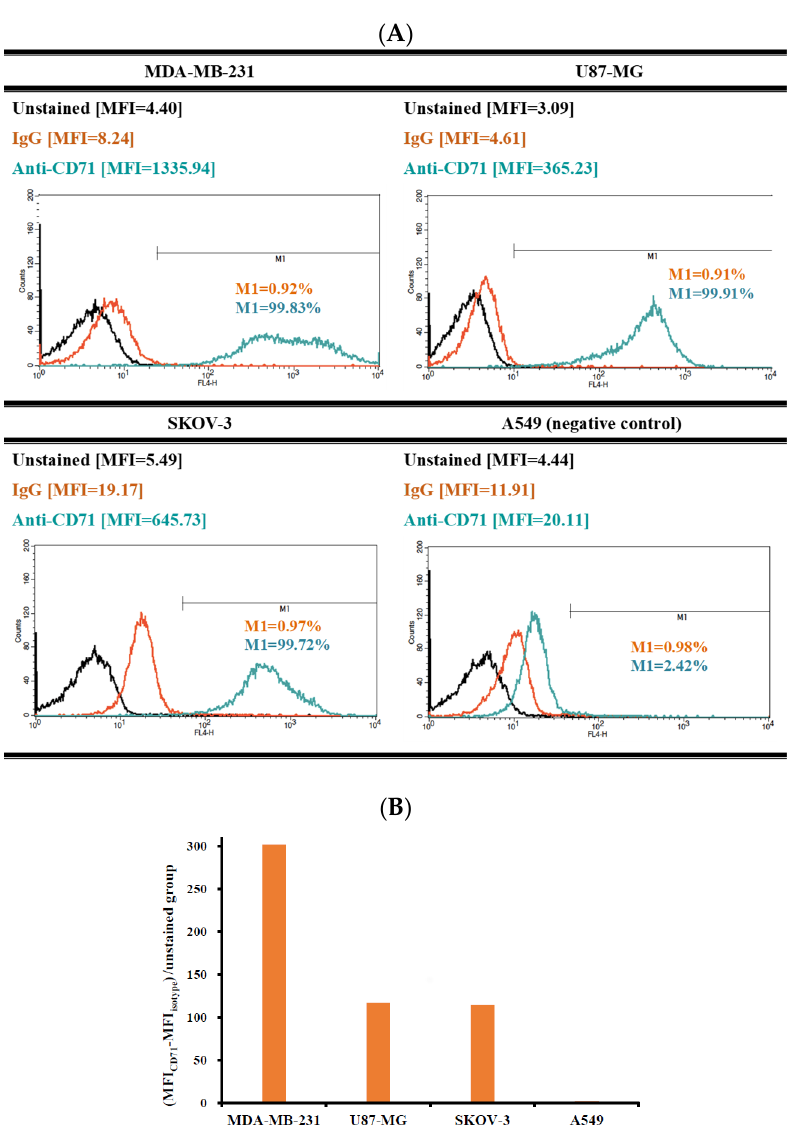
Figure 4. ( A ) The cytometric histograms of various cancer cells stained with anti-human CD71 antibody (green line) and isotype IgG control (orange line), the black line indicated the group without any treatment. ( B ) Transferrin receptor (TfR) expression levels expressed in relative mean fluorescence intensity (MFI) calculated by Equation (3).